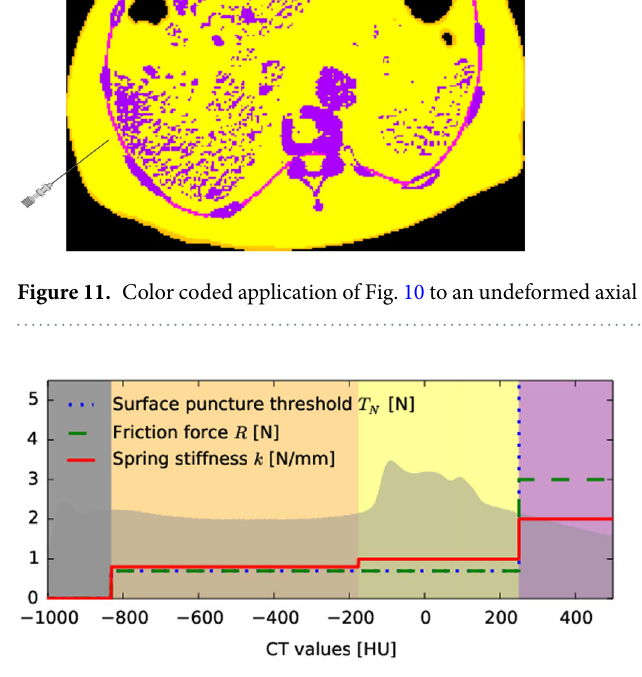
Figure 12. The same as Fig. 10 when the needle has passed the fascia layer (magenta).